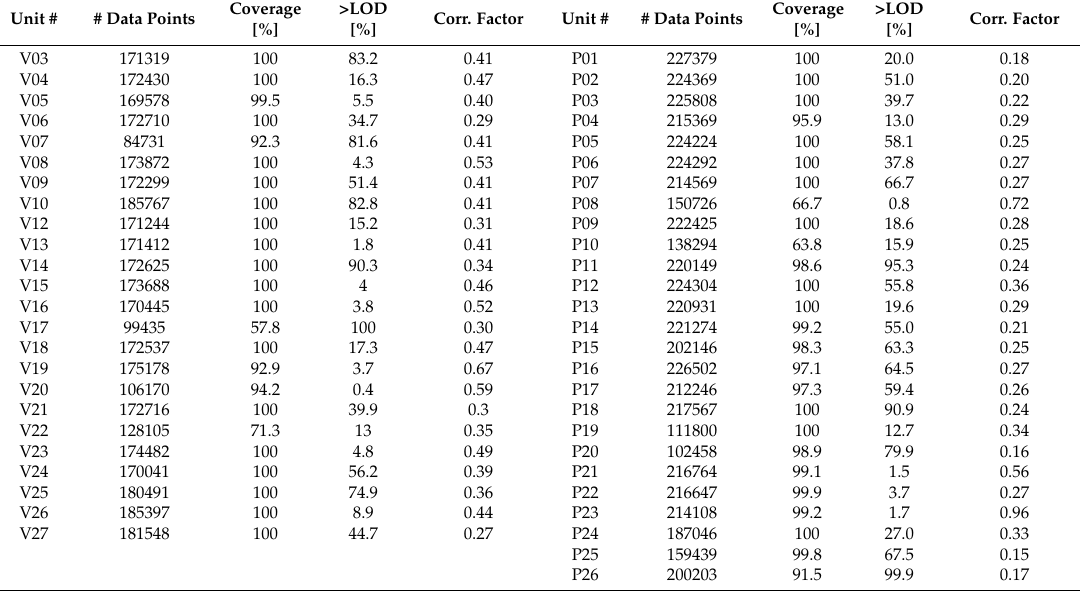
Table 1. Number of measured data points (each corresponding to a 1-min measurement), data coverage of the 50 low-cost measurement units, percentage of data over LOD, and a bias correction factor. Units’ names starting with V denote units measuring during the first year, names starting with P units measuring during the second